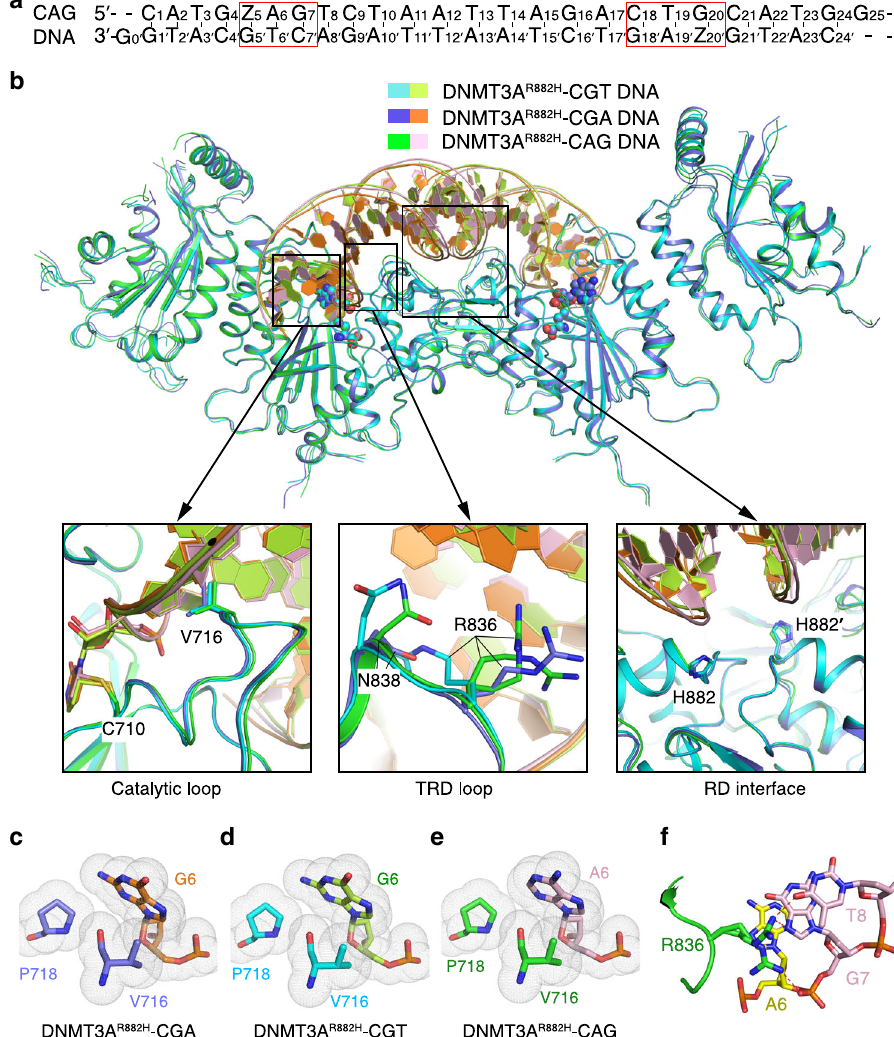
Fig. 5 Structural analysis of the DNMT3A R882H – CAG complex. a DNA sequence (CAG) used for the structural study. b Structural superposition of the DNMT3A R882H – CGA, DNMT3A R882H – CGT and DNMT3A R882H – CAG complexes, with the aligned catalytic loops, TRD loops and RD interfaces shown in expanded views. The side chains of the DNA-contacting residues are shown in stick representation. c – e van der Waals contacts between the catalytic loop (V716 and P718) and the nucleotide downstream of the methylation site (G6 or A6) in the DNMT3A R882H – CGA ( c ), DNMT3A R882H – CGT ( d ) and DNMT3A R882H – CAG ( e ) complexes. f Close-up views of the interaction between TRD residue R836, with two alternative conformations, and the CAG DNA. The hydrogen-bonding interactions are shown as dashed